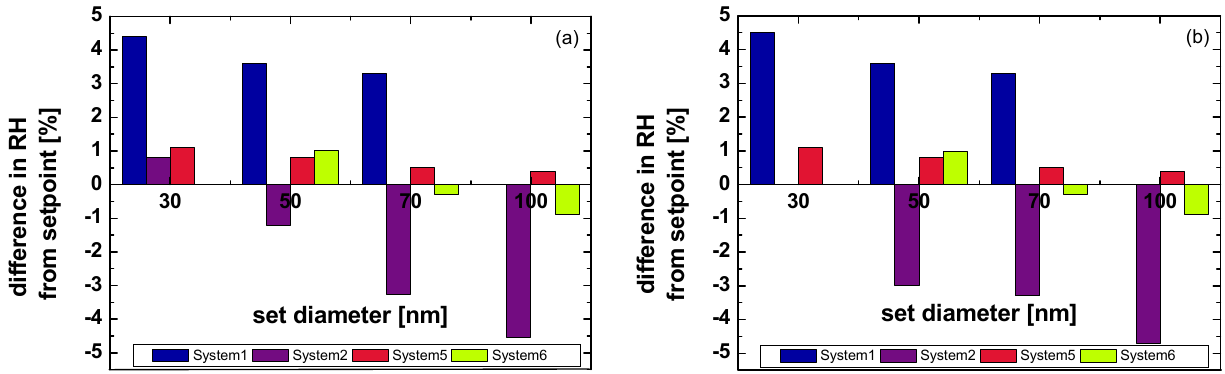
Fig. 3. (a) Externally and (b) internally evaluated RH difference for all systems and Dp =30, 50, 70, and 100nm measured at a set point of